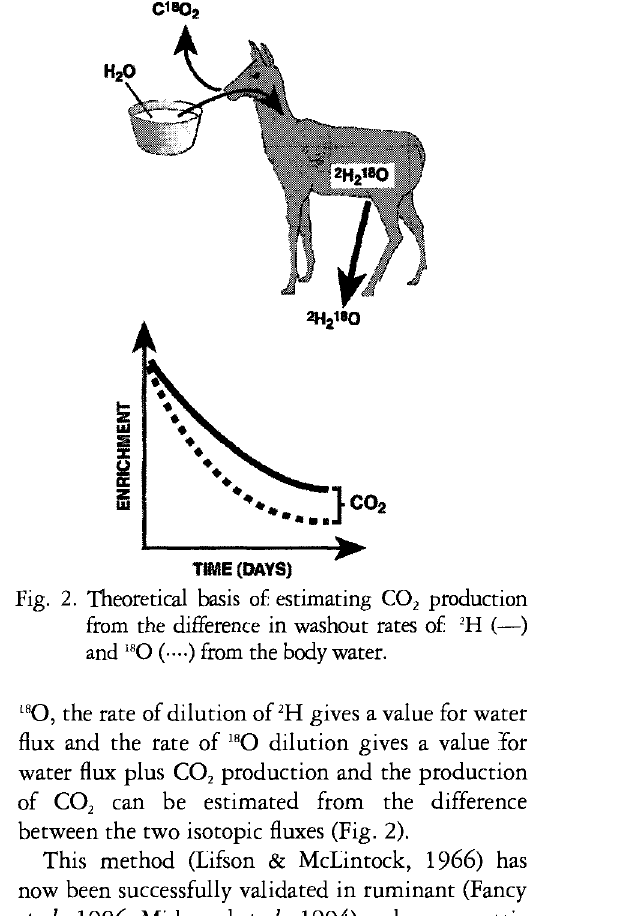
Fig. 2. Theoretical basis of estimating C0 from the difference in washout rates of 3 H (—) and ls O (••••) from the body water. ls O, the rate of dilution of 2 H gives a value for